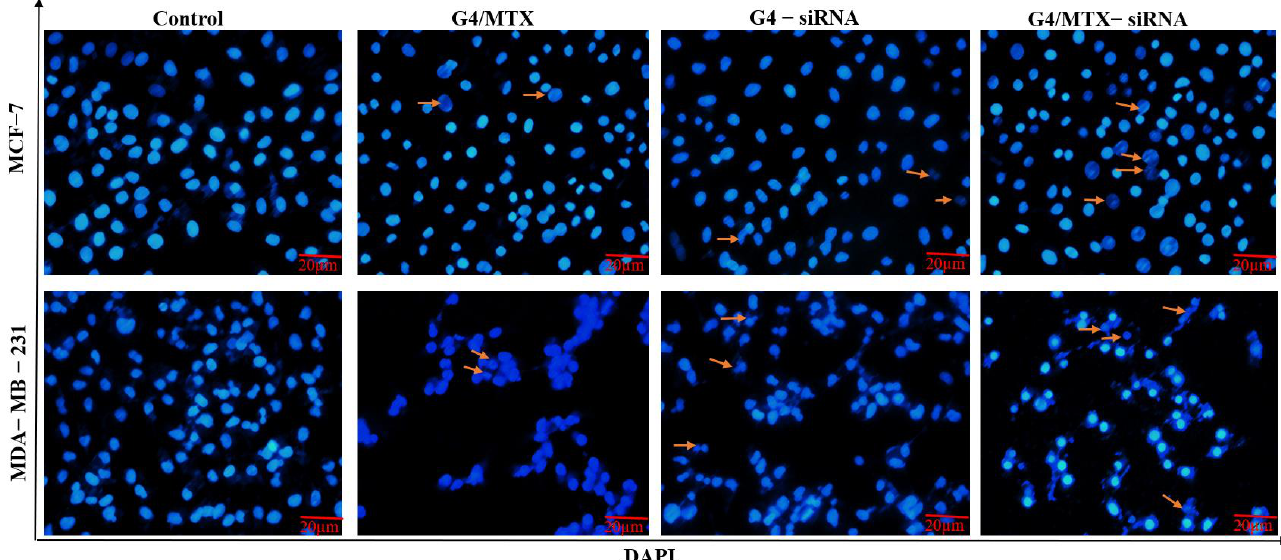
Figure 7. Fluorescence microscopy images of MCF-7 and MDA-MB-231 cells stained with DAPI. Chromatin and DNA fragmentation was observed after cells were treated with G4/MTX, G4-siRNA and G4/MTX-siRNA treatment groups that are represented by the arrows.